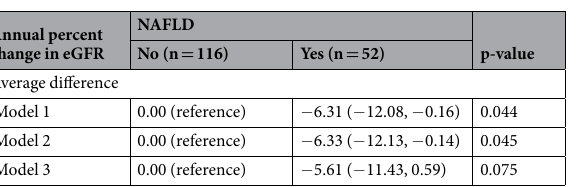
Table 4. Average difference in annual percent change in estimated glomerular filtration rate (eGFR) in CKD patients with eGFR lower than 45 ml/min/1.73 m 2 According to baseline nonalcoholic fatty liver disease (NAFLD) status (n = 168). eGFR, estimated glomerular filtration rate; NAFLD, non-alcoholic fatty liver disease. Model 1: Adjusted for age, sex, and year of visit. Model 2: Further adjusted for baseline smoking status (never, former, current, and missing), alcohol intake (none and moderate), and body mass index. Model 3: Further adjusted for hypertension, diabetes, hyperlipidemia, systolic blood pressure, hemoglobin A1c, LDL cholesterol, and triglycerides (log e